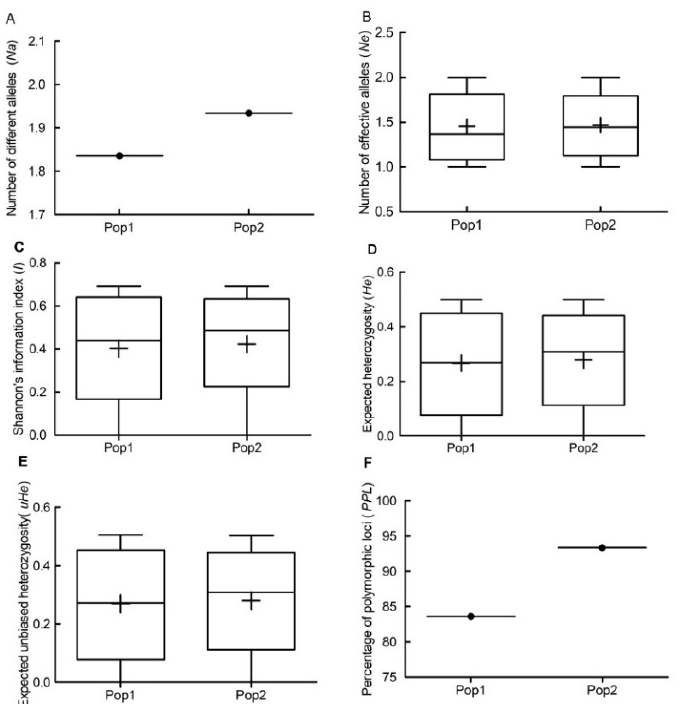
Figure 4. Allelic pattern of SSR across the two sub-populations Pop1 and Pop2. ( A ) Number of SSR alleles ( Na ); ( B ) number of effective SSR alleles ( Ne ); ( C ) Shannon’s information index ( I ); ( D ) expected heterozygosity ( He ); ( E ) expected unbiased heterozygosity ( uHe ); and ( F ) percentage of polymorphic loci ( PPL ).